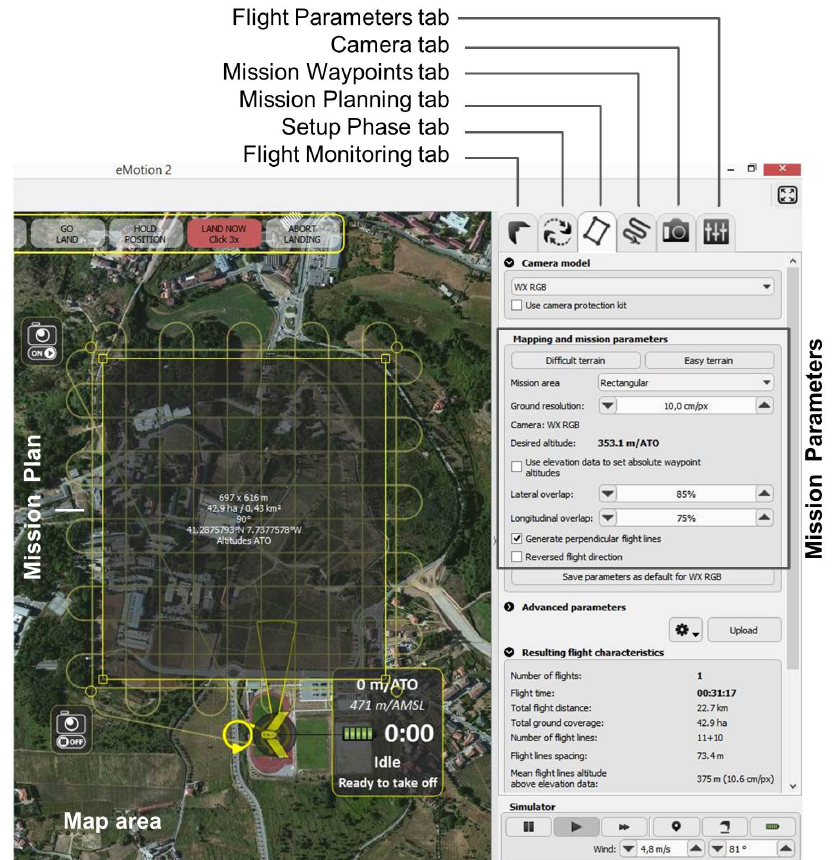
Figure 1. Planning a mission using eMotion software (senseFly SA, Lausanne, Switzerland) adjusting all the required parameters (e.g., lateral and longitudinal overlap, ground